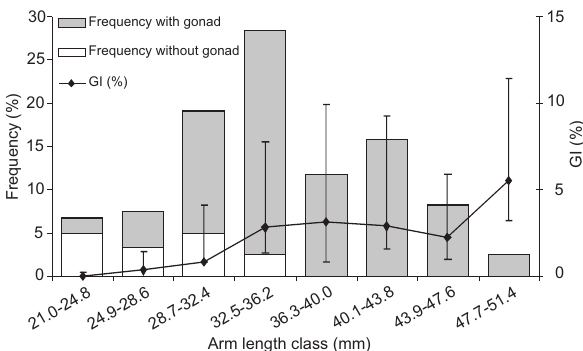
tween 24.80-28.60 mm had gonads, while 100% of the starfish with arm length > 36.20 mm had gonads.